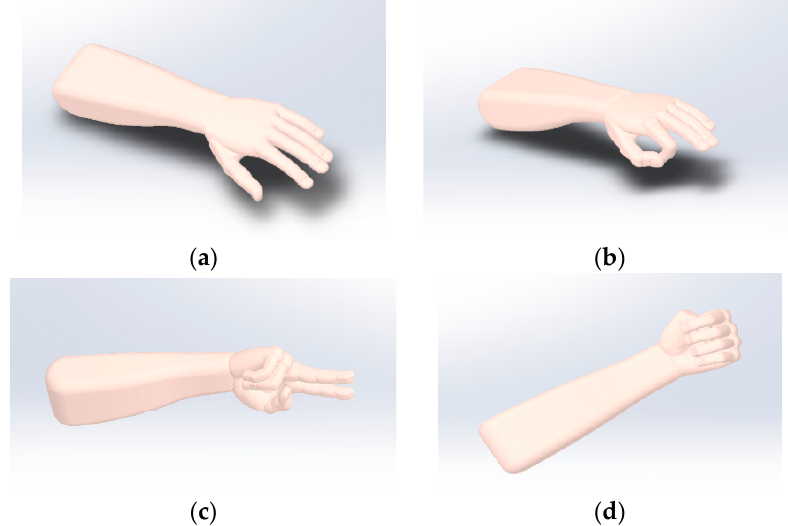
Figure 3. Gesture models: ( a ) stretched hand; ( b ) W-shaped gesture; ( c ) V-shaped gesture; ( d ) fist.